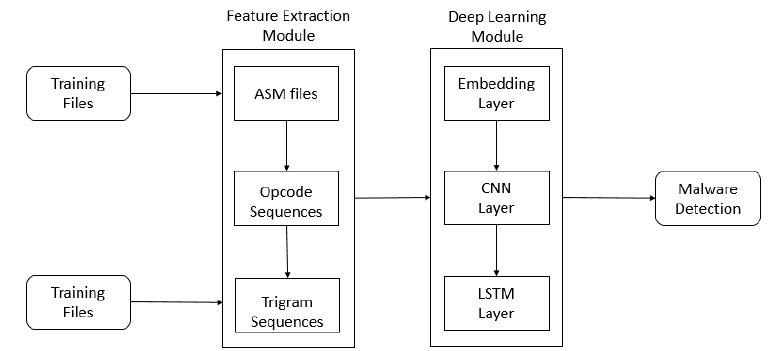
Figure 8. Deep learning–based malware-detection system. ASM: assembler source language.